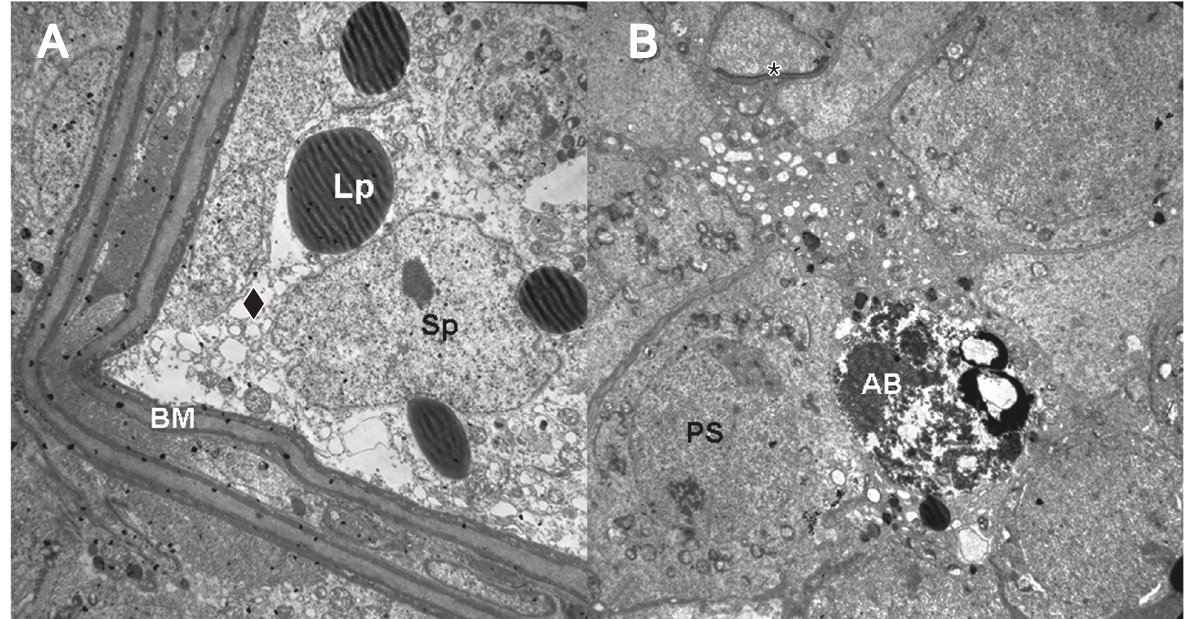
Figure 3. Electron micrograph of the group submitted to total body irradiation. Panel A, Spermatogonium (Sp), lipid droplets (Lp), irregular basement membrane (BM), vacuolar formation of disconnected junctional complexes (black lozenge). Panel B, Primary spermatocytes (PS), a few acrosomal caps (asterisk) and apoptotic bodies (AB) (uranyl acetate and lead citrate staining, 3000X).